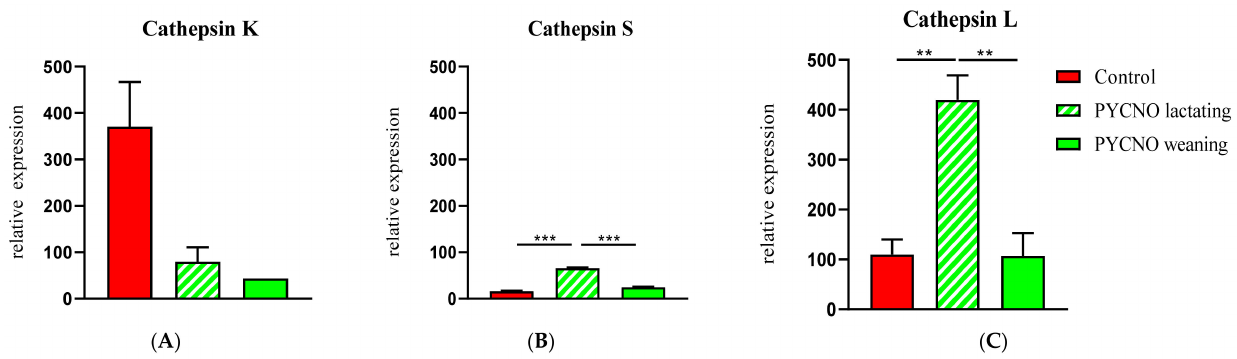
Figure 3. qPCR of cathepsins K, S, and L. Cathepsin K expression was very low in the patient ( A ). During lactation the expression of cathepsin L and S ( B , C ) was significantly elevated in the osteoclasts of the PYCNO patient. ** p < 0.01; *** p <